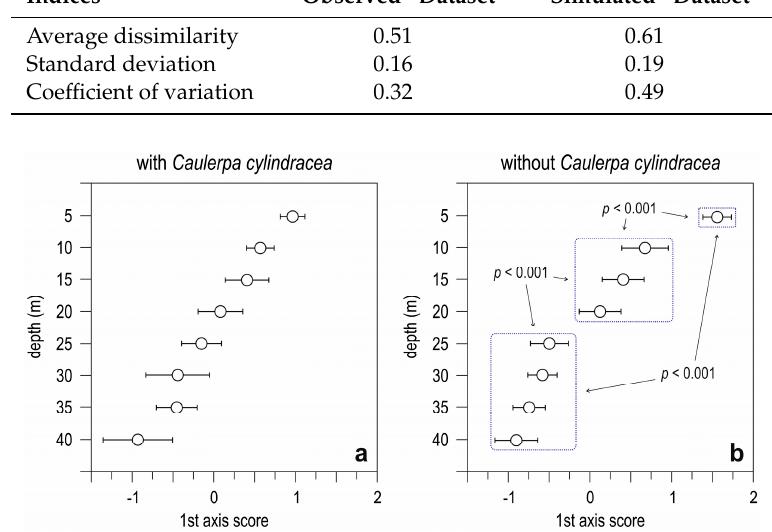
Figure 7. Relationship between PCA first axis scores and sample depth for both the “observed” ( a ) and the “simulated” datasets ( b ). In both graphs, circles represent mean scores and error bars are the 95% confidence limits. In the “observed” dataset no discontinuity is apparent, while in the “simulated” dataset three groups can be distinguished (dotted line rectangles). All differences in first axis scores for the three groups are highly significant (Tukey's pairwise comparisons).